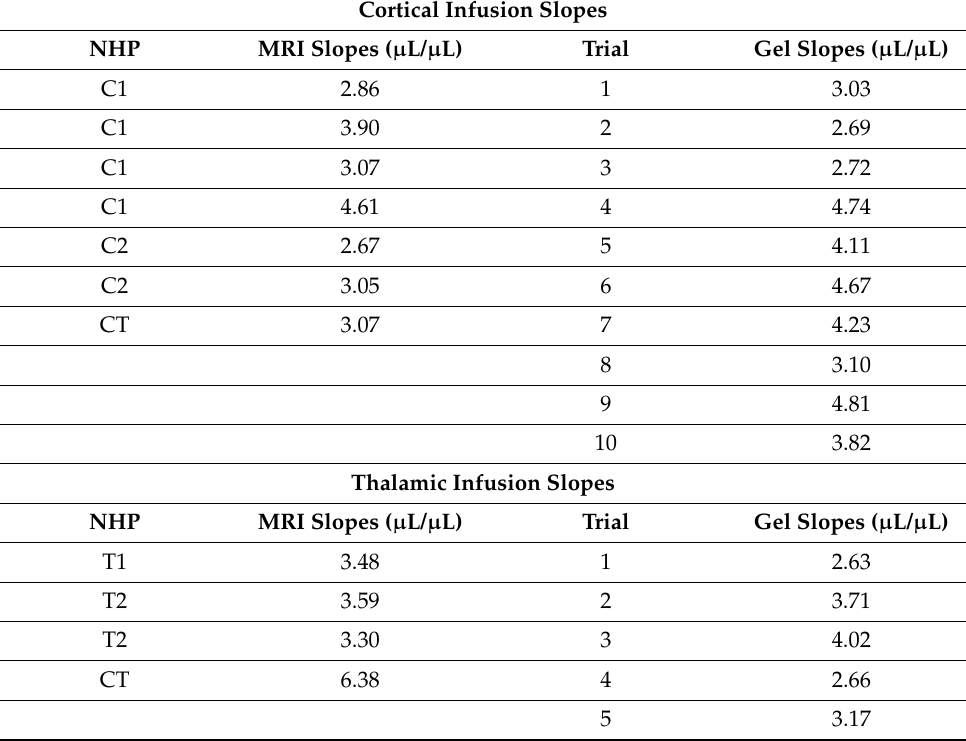
Table 4. Cortical and thalamic